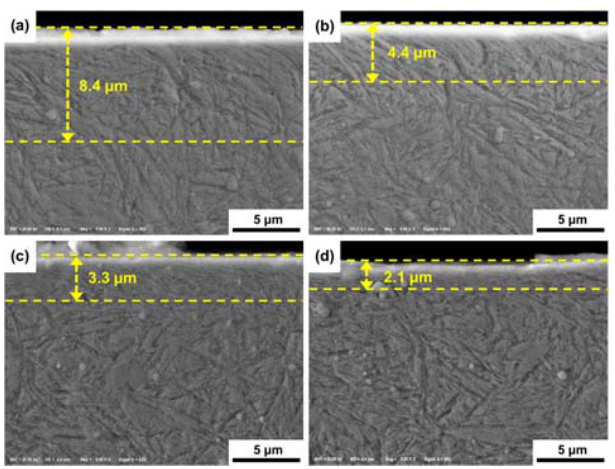
Figure 12. Cross ‐ sectional microstructure after wear test of the M50 steel with different USP dura ‐ tions: ( a ) 0 min; ( b ) 1 min; ( c ) 5 min; ( d ) 10 min. ( a ) 0 min; ( b ) 1 min; ( c ) 5 min; ( d ) 10